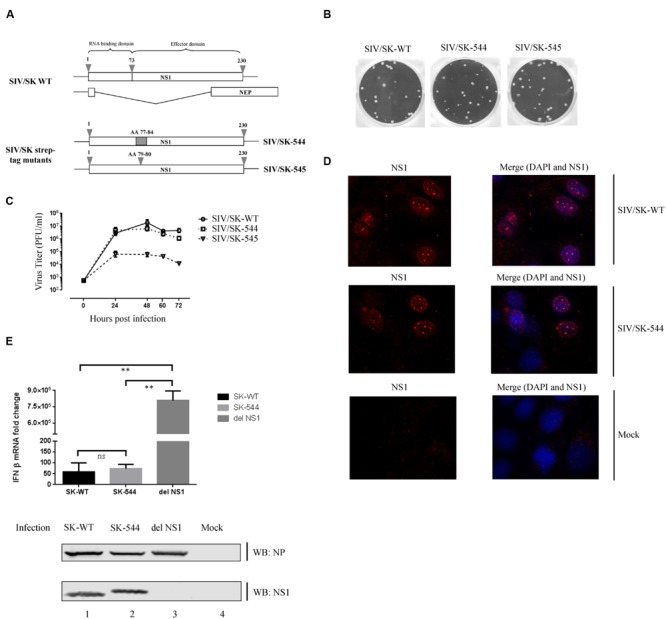
Characterization of recombinant Strep-tag NS1 viruses. (A) A schematic representation of the NS1 protein and the location of the Strep-tag replacement and insertion within the NS1 protein sequence. (B) MDCK cells were infected with either the WT virus or the recombinant Strep-tag viruses. At 48 h.p.i., plaques were visualized by staining with coomassie blue. (C) MDCK cells were infected with either the WT virus or the recombinant Strep-tag viruses at an MOI of 0.001 in triplicates. Supernatant was collected every 24 h and the titer was determined by plaque assay on MDCK cells. A growth curve was plotted using the mean titer values at each time point and the associated standard deviation is displayed as error bar. (D) MDCK cells were infected with either the WT virus or the mutant SIV-SK/544 virus at an MOI of 2. At 8 h.p.i., the cells were fixed, permeabilized and stained with rabbit anti-NS1 serum followed by Alexa Fluor 594-conjugated anti-rabbit antibody (red) and mounted with a mounting media containing DAPI stain (blue). A representative image of multiple fields of view is shown. (E) NPTr cells were infected with SIV/SK-WT, SIV/SK-544, or PR8 del NS1 virus at an MOI of 1. At 12 h.p.i., the cell lysate was collected and RNA was extracted. The RNA was reverse transcribed and the cDNA was then used in qPCR experiments to determine IFNβ mRNA expression. Real-time PCR was conducted in triplicate for each sample and the mean value was calculated. Final figures represent the results from three independent experiments and the associated standard deviation is displayed as an error bar. Significant differences between treatments and controls are represented by an asterisk (p < 0.05) or two asterisks (p < 0.01). Samples with p < 0.05 were considered statistically significant, while p > 0.05 was considered not significant (ns). The expression of viral proteins present in the infected cell lysate was detected by Western blotting.